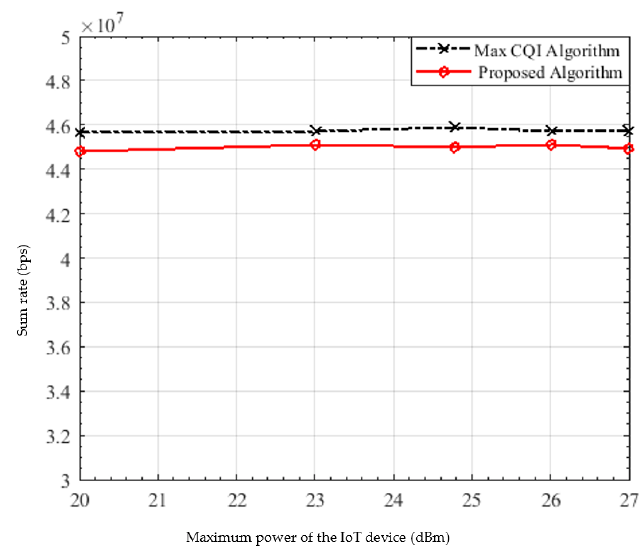
Figure 7. Sum rate versus the power of the IoT devices.